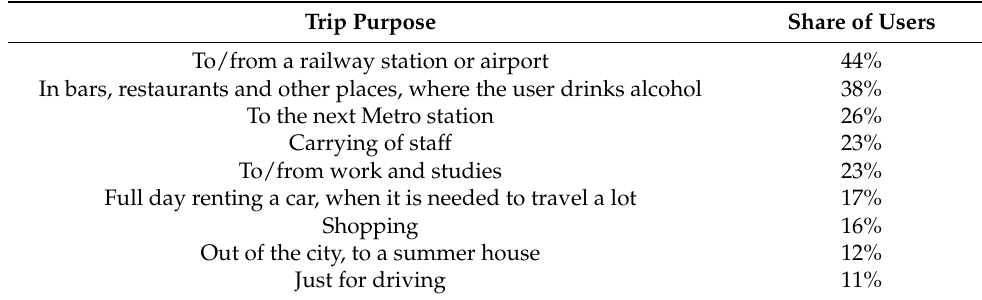
Table 2. The trip purpose of Yandex.Drive users 1 . Trip Purpose Share of Users To/from a railway station or airport 44% In bars, restaurants and other places, where the user drinks alcohol 38% To the next Metro station 26% Carrying of staff 23% To/from work and studies 23% Full day renting a car, when it is needed to travel a lot 17% Shopping 16% Out of the city, to a summer house 12% Just for driving